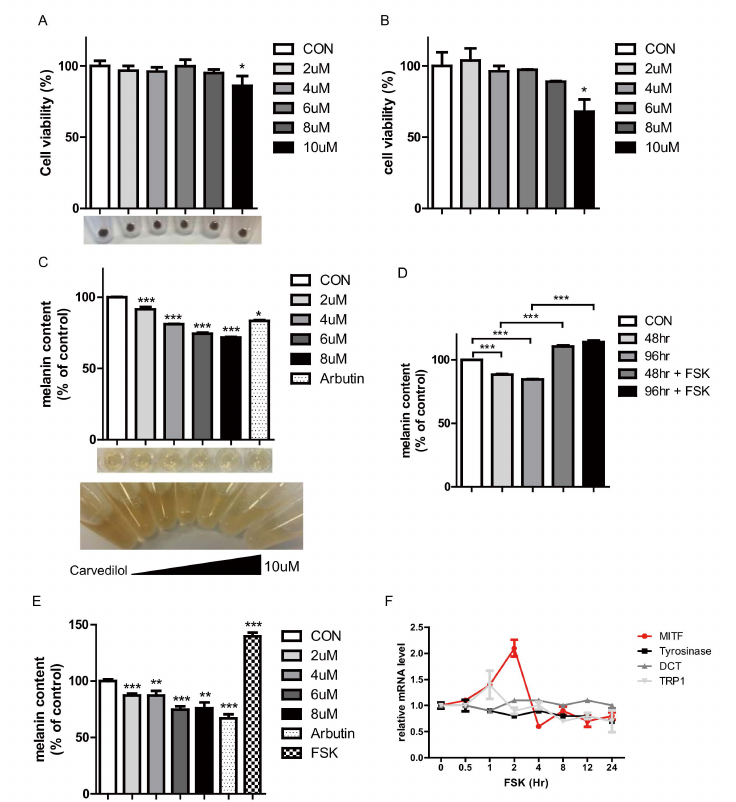
Figure 1. E ff ect of carvedilol on melanin production in normal human melanocytes (NHMs) and Mel-Ab cells without a ff ecting cell viability. ( A ) Cell viability was measured using the WST assay in NHMs. NHMs were treated with 2–10 µ M carvedilol for 5 days. ( B ) Cell viability was measured using the WST assay in Mel-ab cells. Mel-ab cells were treated with 2–10 µ M carvedilol for 3 days. ( C ) E ff ect of carvedilol on the cellular melanin content when NHMs were treated with the indicated concentrations of carvedilol for 5 days. ( D ) Melanin content of NHMs at 48 and 96 h after treatment with vehicle control, 8 µ M carvedilol, and carvedilol with 10 µ M forskolin (FSK). ( E ) Melanin content of Mel-Ab cells treated with indicated concentrations of carvedilol for 72 h. ( F ) Time-dependent curve of mRNA levels of microphthalmia-associated transcription factor ( MITF ) in NHMs treated with 10 µ M FSK for up to 24 h. FSK increased the transcription of MITF to the greatest degree at 2 h in NHMs, possibly via the cAMP / PKA / CREB pathway. Time-dependent curve of the mRNA levels of tyrosinase, DCT , and TRP1 in NHMs treated with 10 µ M FSK for up to 24 h. Data are expressed as means ± SD of three independent experiments. * p < 0.05, ** p < 0.01, *** p < 0.001 vs.